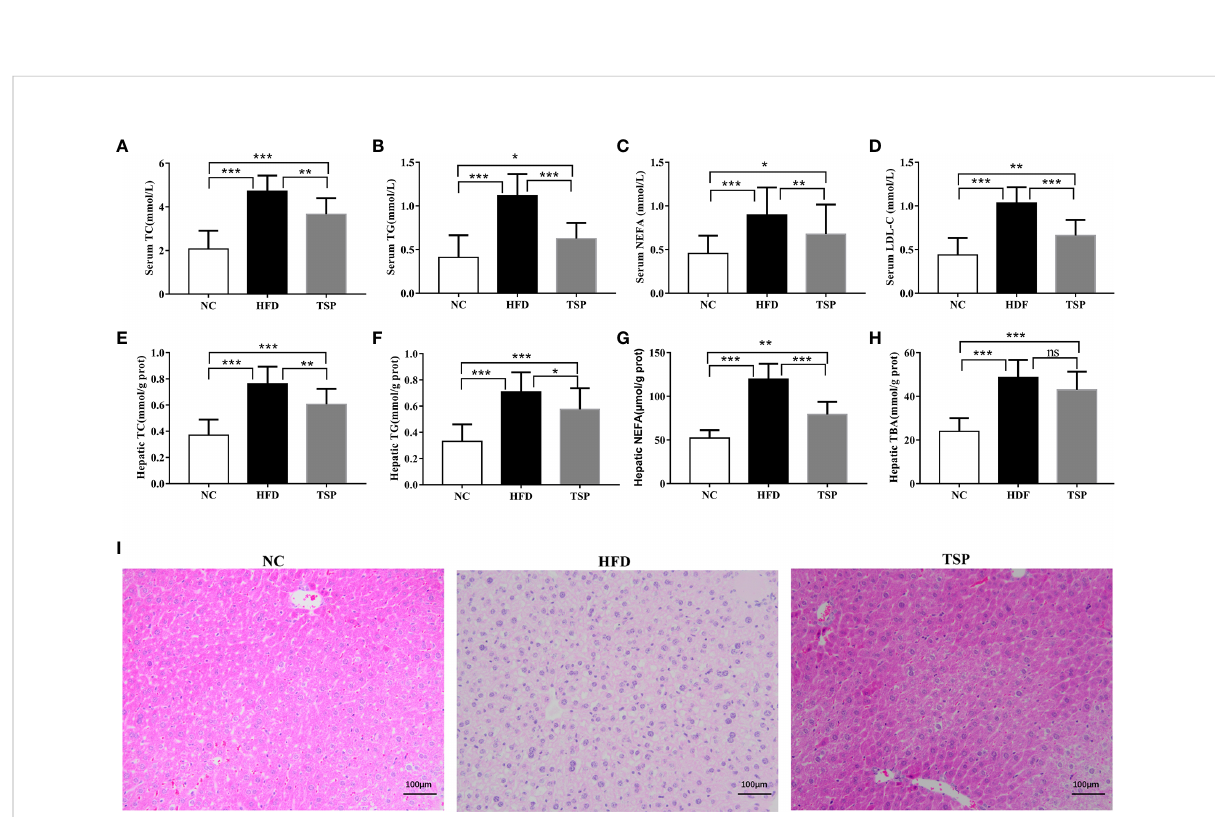
FIGURE 2 Effects of TSP supplementation on the serum and hepatic (A, E) total cholesterol (TC), (B, F) triglyceride (TG), (C, G) non-esteri fi ed fatty acid levels (NEFA), (D) low-density lipoprotein cholesterol (LDL-C) in serum, (H) Hepatic total bile acid (TBA), (I) H&E staining of mouse livers. Values are expressed as mean ± SD in each group (n = 8), * p < 0.05, ** p < 0.01, and *** p < 0.001, ns, no signi fi cant p > 0.05.